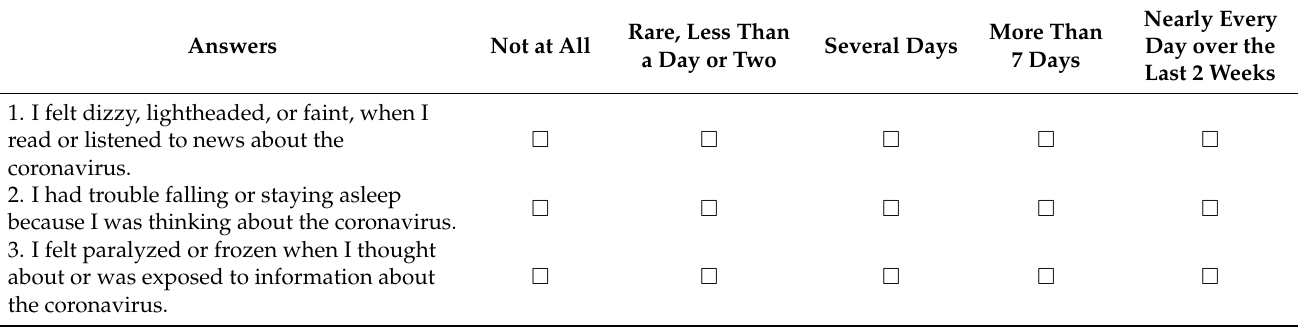
Table A3. Items of the Coronavirus Anxiety Scale (English